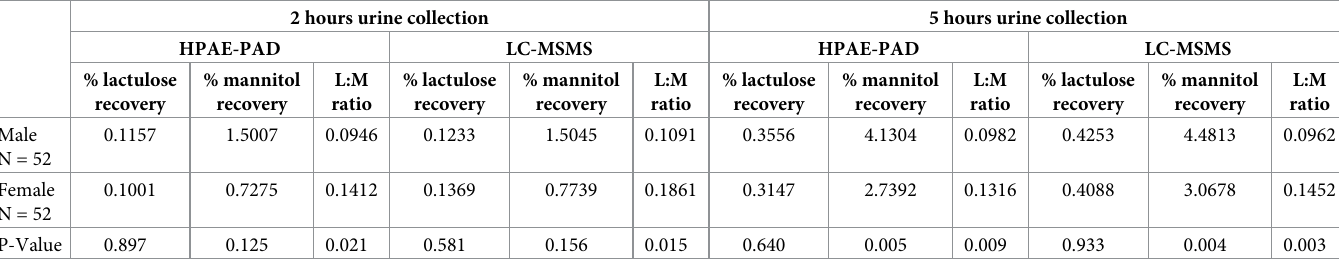
Table 3. Lactulose mannitol test results of male and female